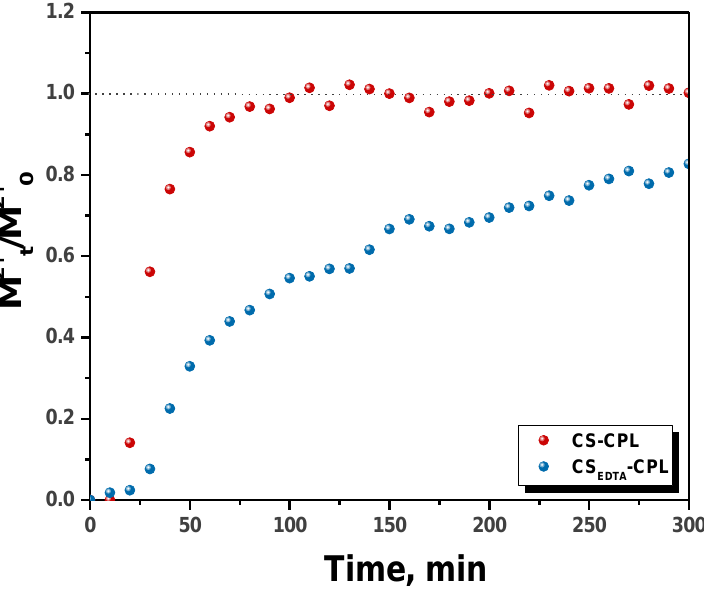
Figure 4. The CS-CPL and CS EDTA -CPL columns saturation with HMIs as a function of time.